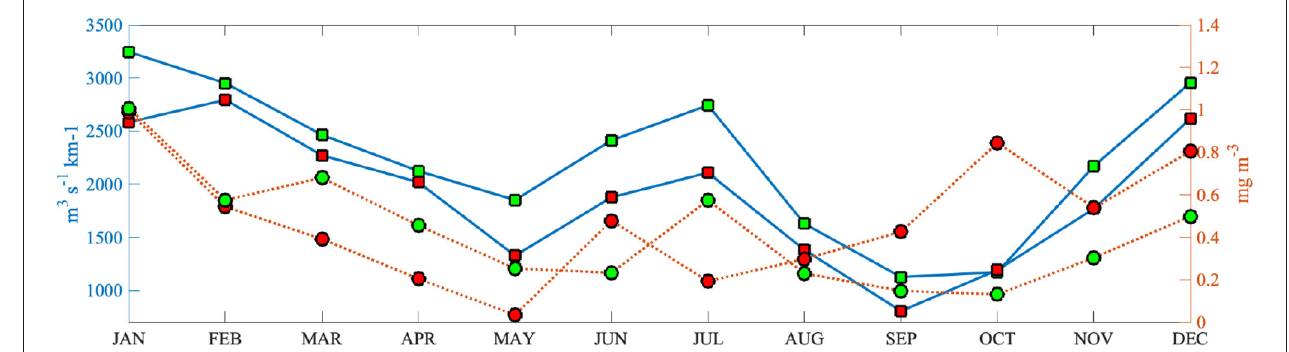
FIGURE 7 | Monthly averaged cross-shore Ekman transport (squares) at ADCP1 (red) and ADCP2 (green) and monthly averaged surface Chl-a (dots) at ADCP1 (red) and ADCP2 (green) for the period between 2007 and 2012. Surface wind data is described in section